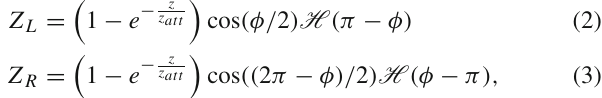
defined as the lower edge of the IV and OV (see Fig.